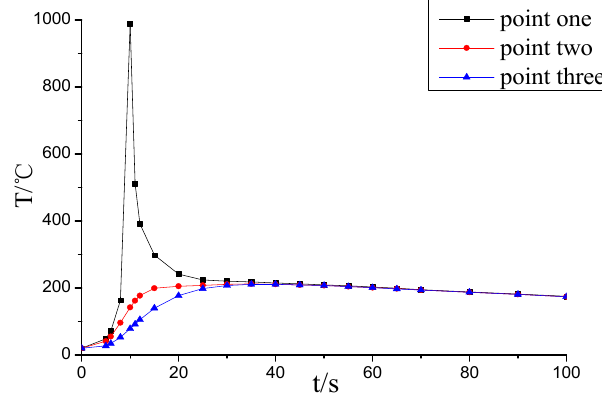
Figure 11. Thermal cycle curves of the experiment.